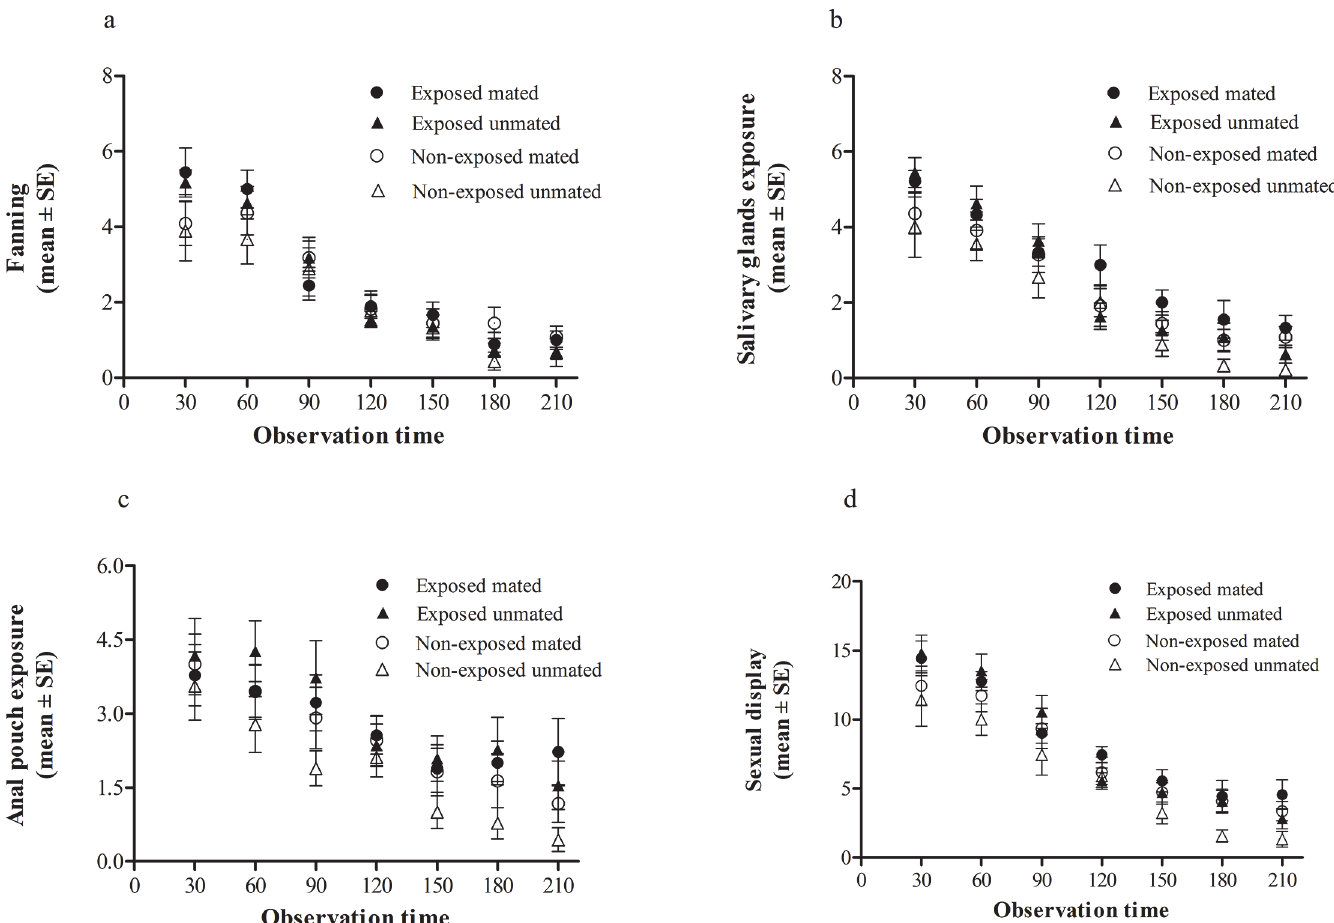
Fig 3. Temporal pattern of the different components of Anastrepha fraterculus wild male´s sexual behavior. a) Number of males fanning their wings along the 210 minutes of observation time (mean ± SE) (GLM, P = 0.223 for wing fanning). b) Number of males exposing their salivary gland (mean ± SE) (GLM, P = 0.007 for salivary gland). c) Number of males exposing their anal pouch (mean ± SE) (GLM, P = 0.080 for anal pouch). d) Sexual displays which results from adding the three recorded behavioral parameters (mean ± SE) (GLM, P = 0.024 for sexual display). Mean values are presented separately in all male treatments. In all cases GLM showed significant differences at P < 0.0001 for observation time and non-significant differences neither for mating status, nor for any